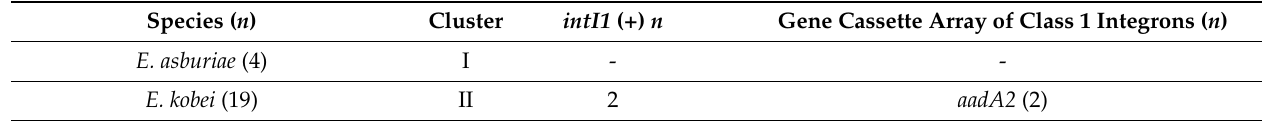
Table 4. Class 1 integrons and their gene cassettes in species of Enterobacter